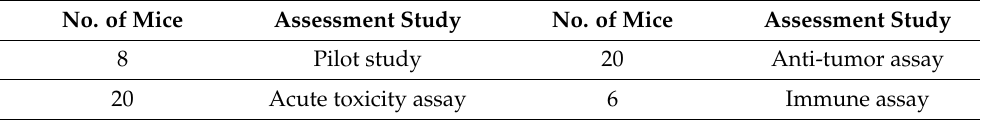
Table 7. The distribution of mice on different experiments. No. of Mice Assessment Study No. of Mice Acute toxicity assay Immune